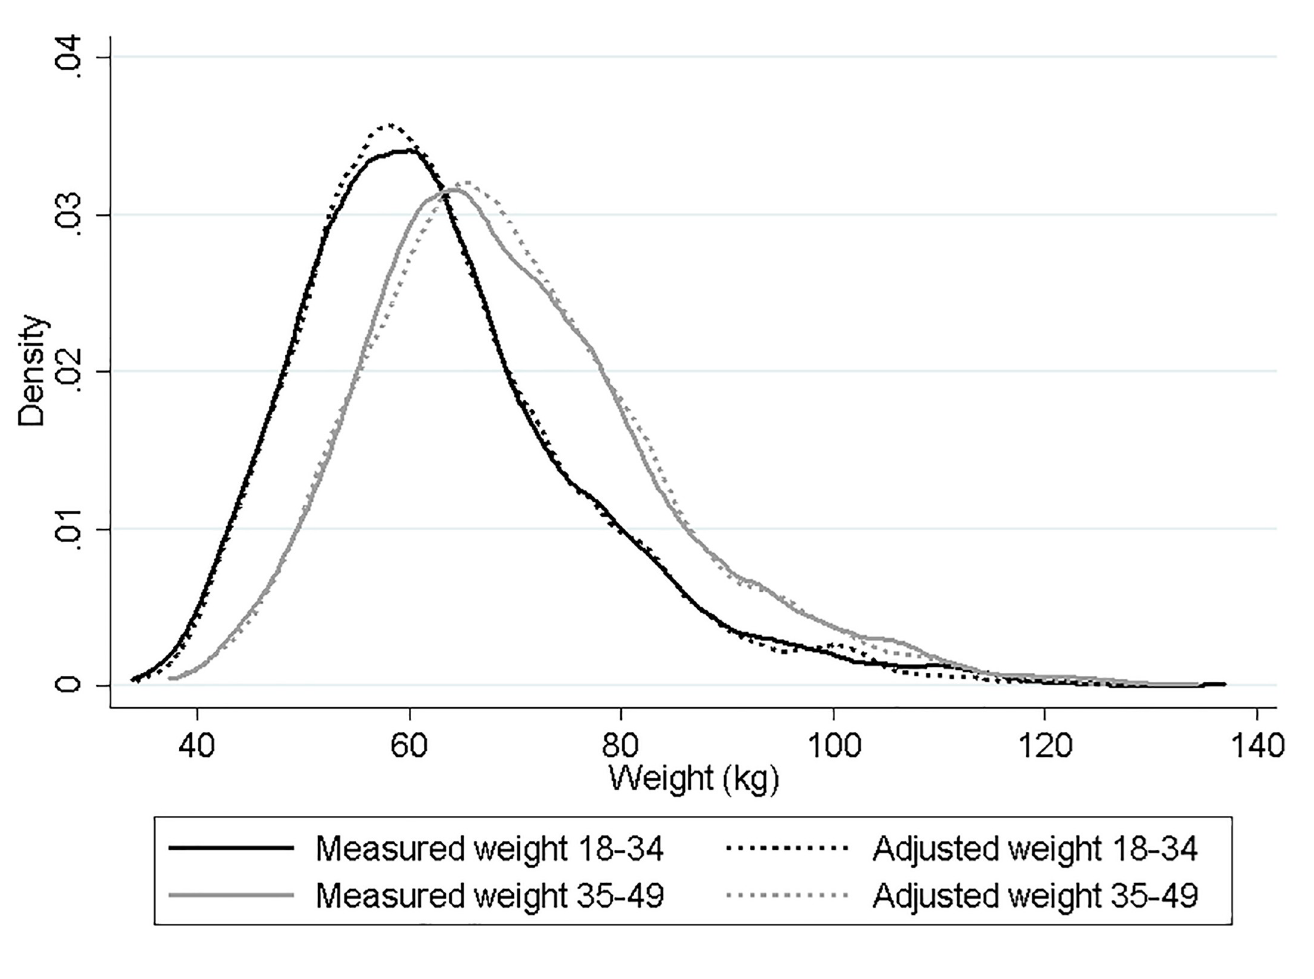
Fig 2. Density distribution of measured weight and adjusted weight by age group.